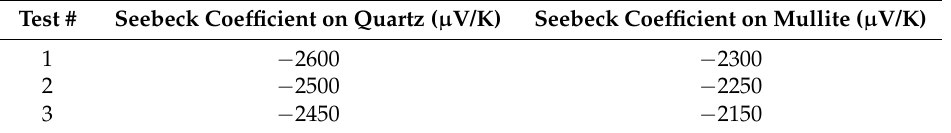
Table 1. Degradation of Seebeck coefficients of ML thin films on different substrates tested at 870 K. Test #